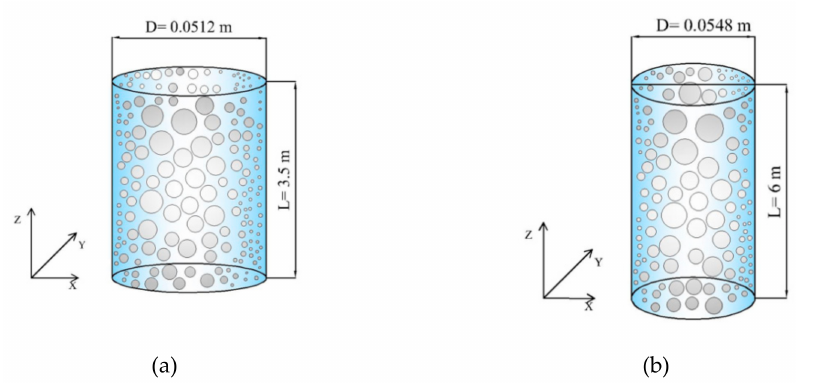
Figure 1. Bubble column geometry studied by ( a ) The computational domain of Test 1 Lucas et al. [51] and ( b ) The computational domain of Test 2 Banowski et al. [52].